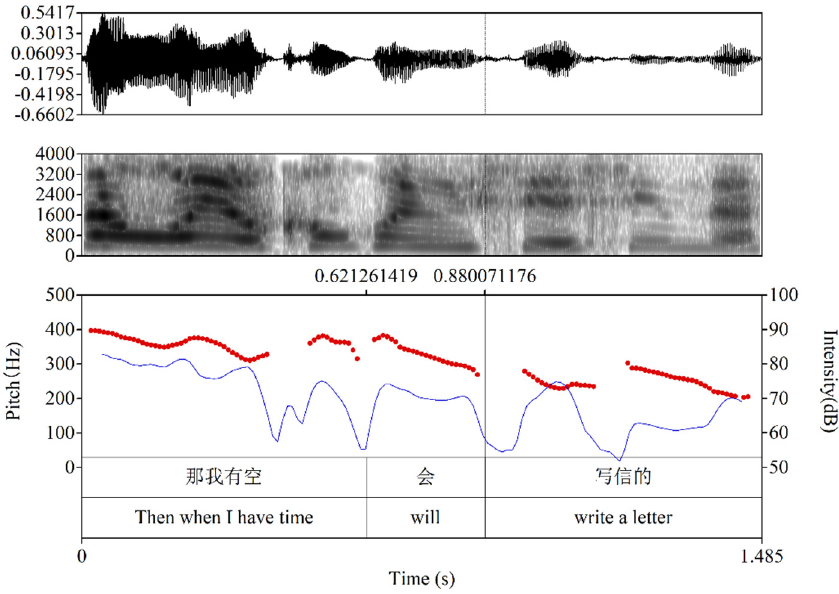
Figure 9 . Waveform, spectrogram, pitch contour, and intensity of line 29 in Ex 20 . Figure 9. Waveform, spectrogram, pitch contour, and intensity of line 29 in Ex